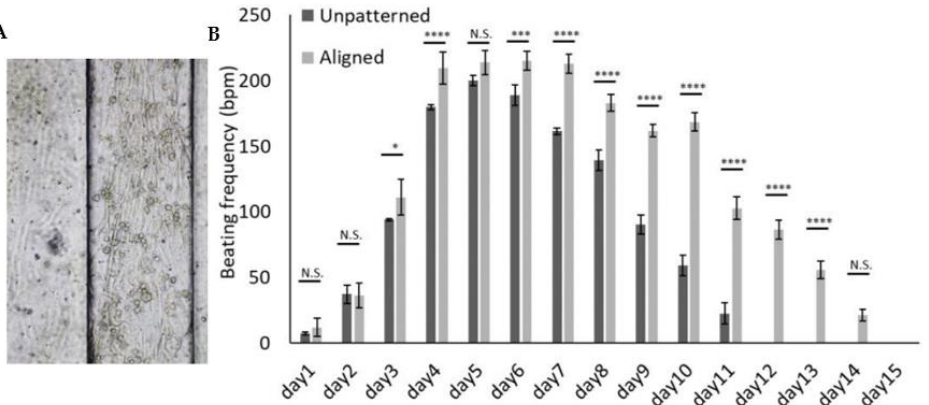
Figure 4. The beating behavior of the cells. ( A ) Neonatal cardiac cell alignment in the microgrooves. ( B ) The comparison between the beating frequency in the 3D dECM-fibrin hydrogel, with and without patterning. Two-way ANOVA with multiple comparison showed significant difference from day 3 between two groups. Scale bar: 100 µm. N.S. = p > 0.05, * = p ≤ 0.05, *** = p ≤ 0.001, **** = p ≤ 0.0001.